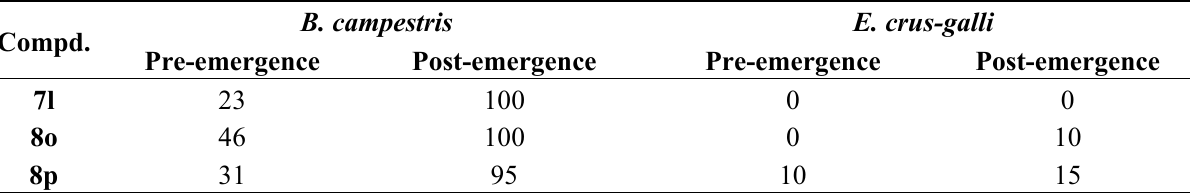
Table 2. The herbicidal activities (efficacy, %) of compounds 7l , 8o and 8p in greenhouse test. Compd.